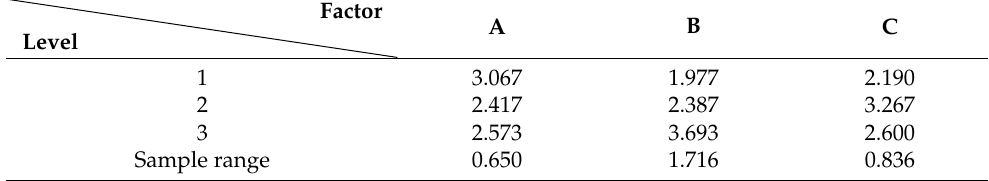
Table 4. Mean and range of tensile strength for each factor at each level (unit: MPa). Factor Level